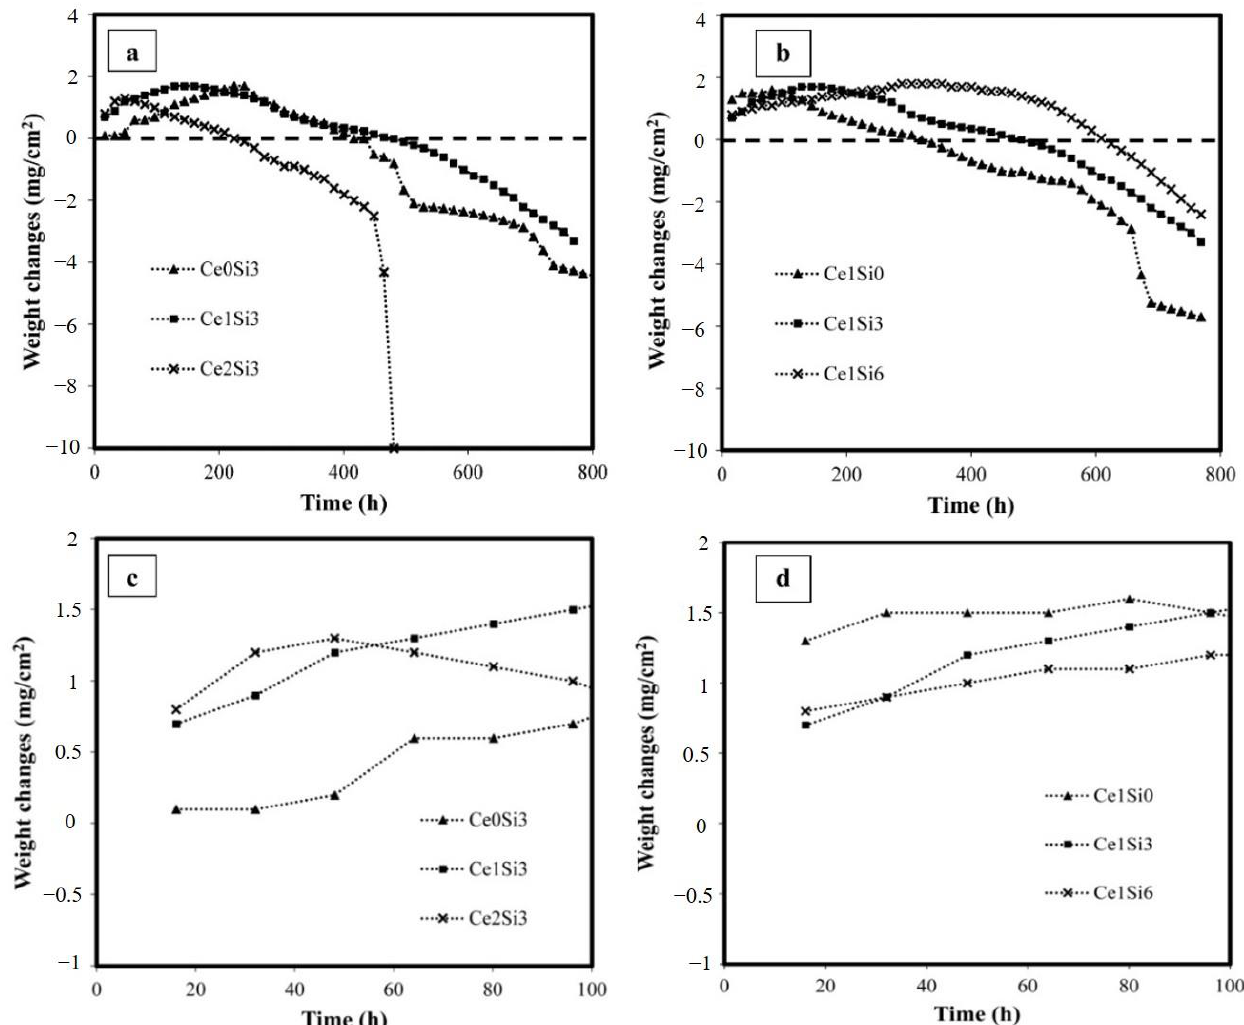
Figure 6. Cyclic high-temperature oxidation of Ce-Si-modified aluminide coatings at 1100 °C for 800 h. ( a ) For samples Ce0Si3, Ce1Si3, and Ce2Si3, ( b ) for samples Ce1Si0, Ce1Si3, and Ce1Si6, and ( c ) and ( d ) show the beginning of the oxidation test in detail.